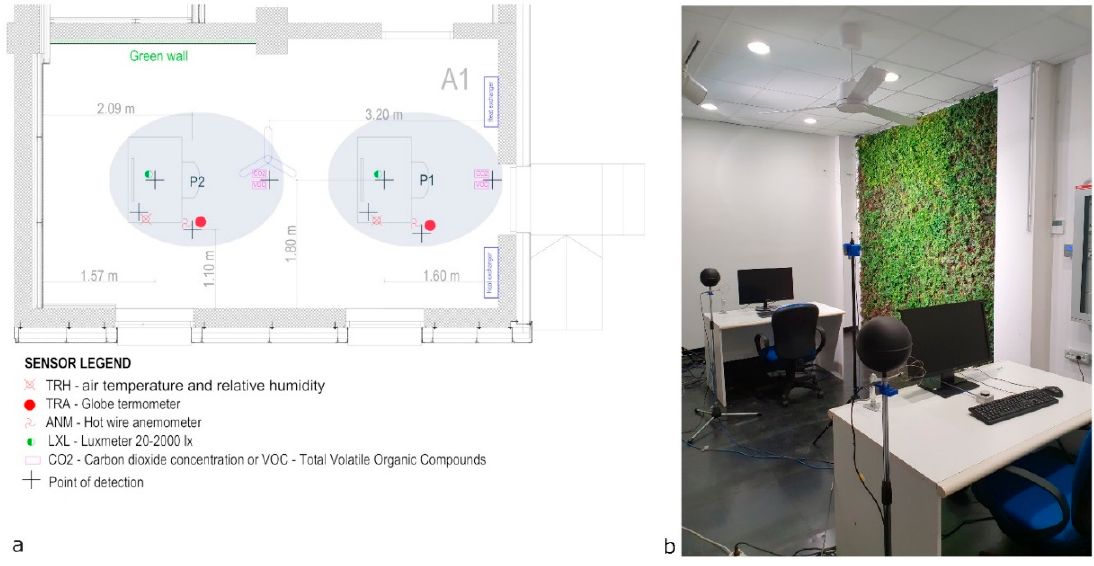
Figure 2. A1 room: ( a ) spatial distribution of sensors; ( b ) photo of the room set up.